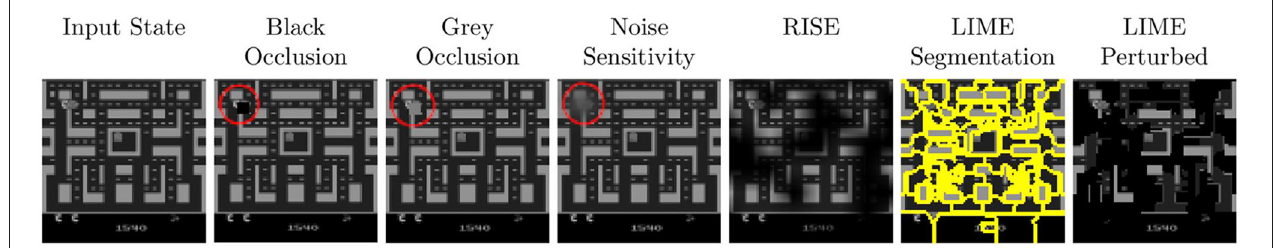
FIGURE 1 | An example of the different types of perturbation used by the saliency map approaches in our work. The parameters are chosen in such a way that the idea of the perturbation can be easily identified. For Occlusion and Noise, the disturbed area is marked with a red circle.